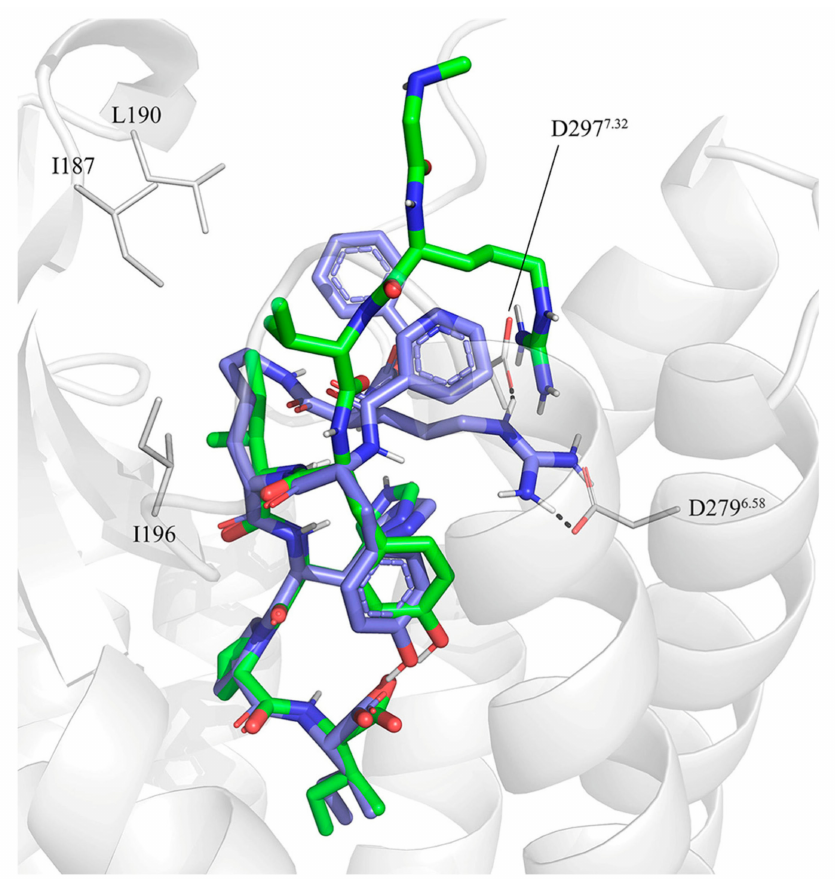
Figure 2. Initial docking of CGP42112A, compound 2 (violet) superimposed to the crystal structure of sarile ( 1 ) (green) in complex with AT2R. Dashed lines indicate the conserved salt bridge between Arg 2 and D279 6.58 and D297 7.32 (lines). The lipophilic sidechains of AT2R surrounding the equivalents of Ile 5 and Val 3 in 1 are also